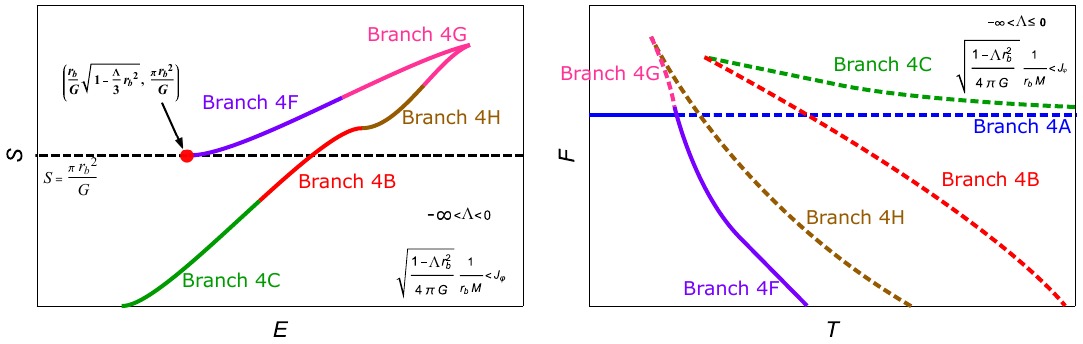
Figure 19 . Qualitative behavior of entropies against energy and that of free energy against temper- ature when −∞ < Λ ≤ 0 and